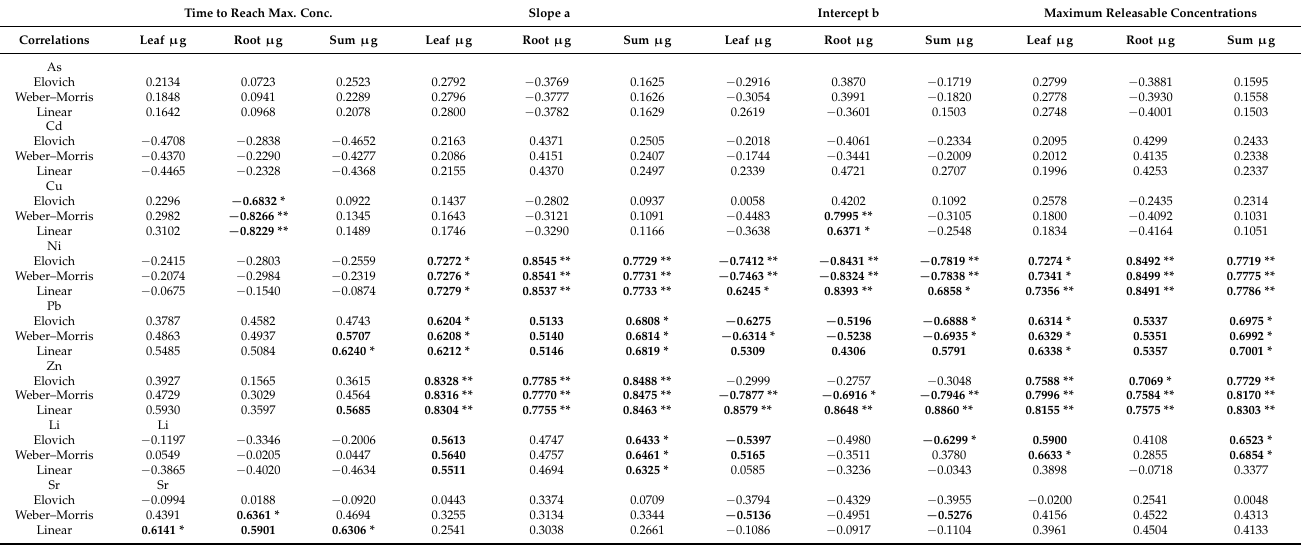
Table 4. Correlation coefficients between the contents in cropped lettuce and the kinetic parameters obtained from modelling the EUF data.